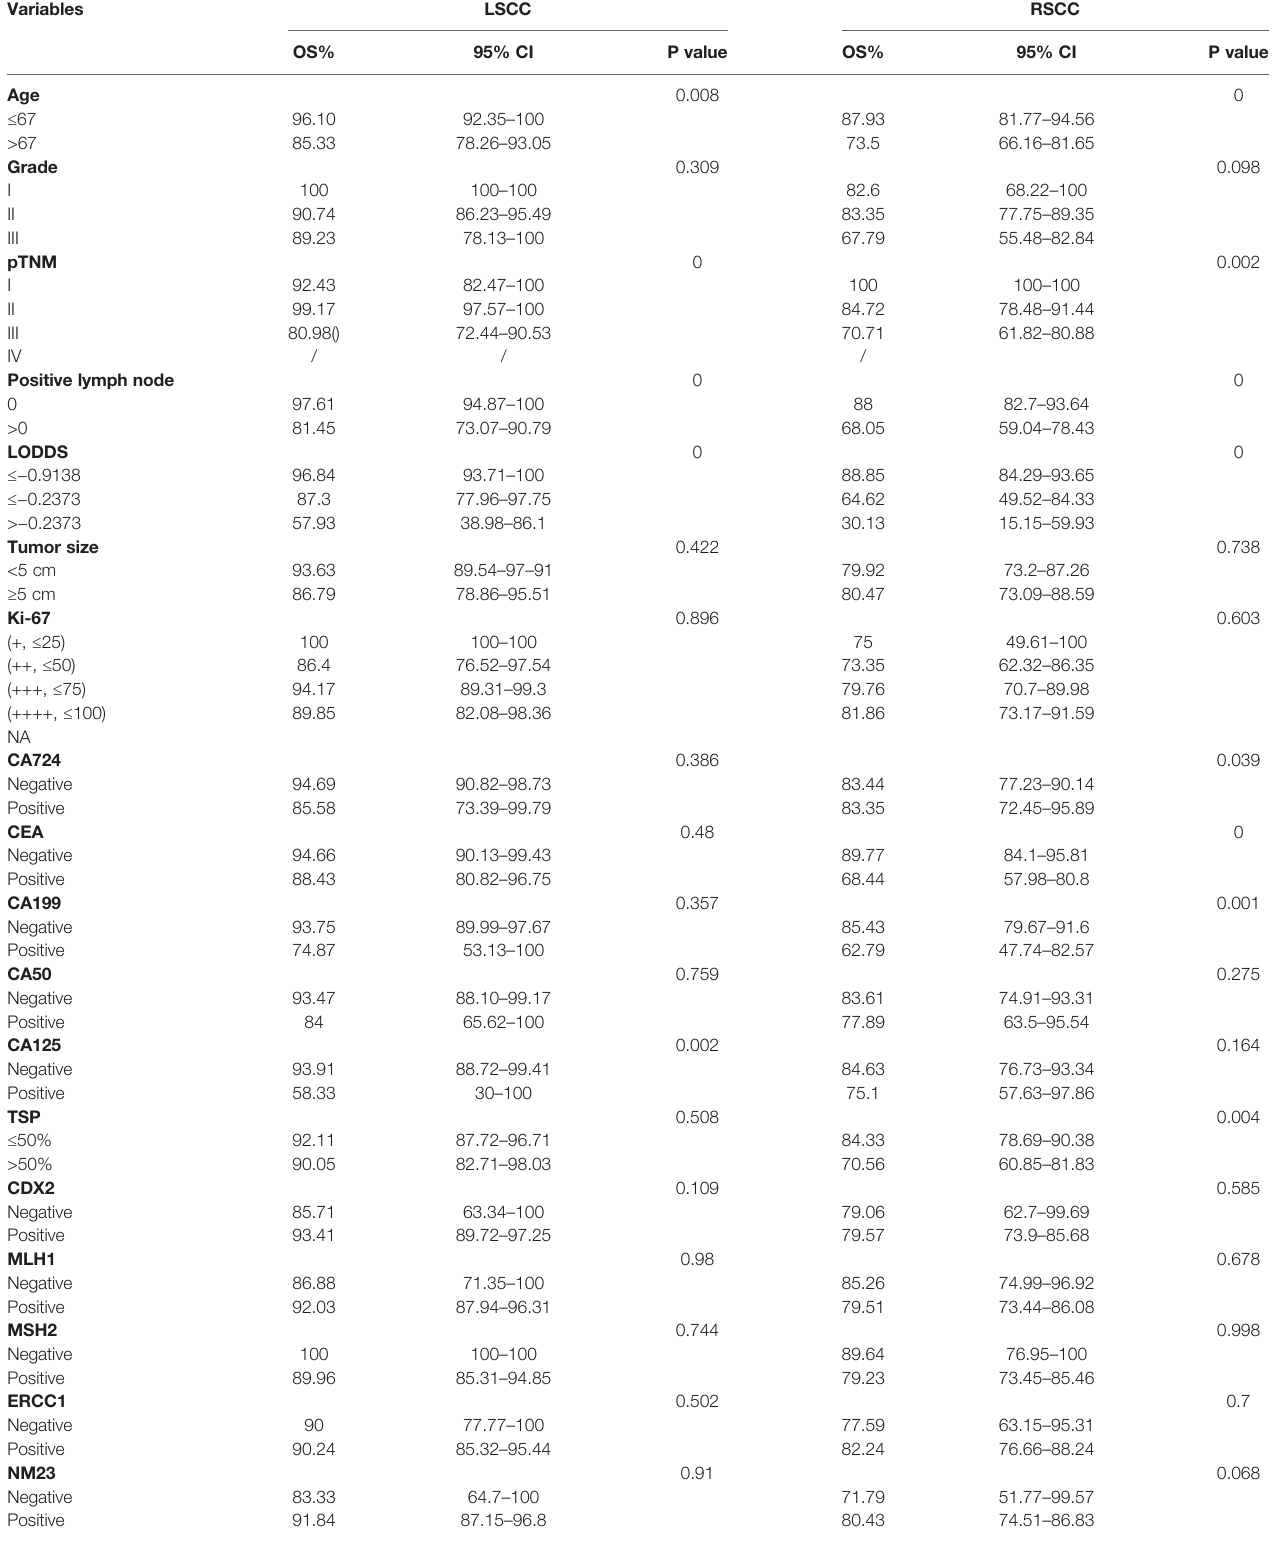
TABLE 2 | Univariate analyses of risk factors associated with overall